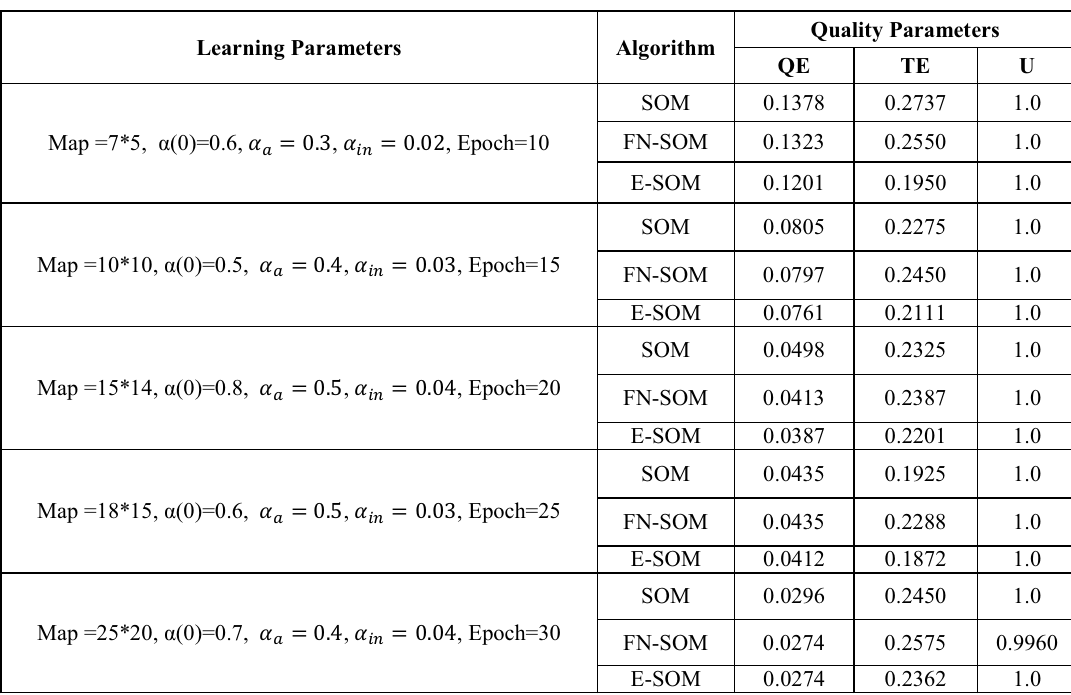
Table 2. Quantization error Qe, Topographic error Te and Neuron Utilization U for the 2-Diamonds dataset (Experiment